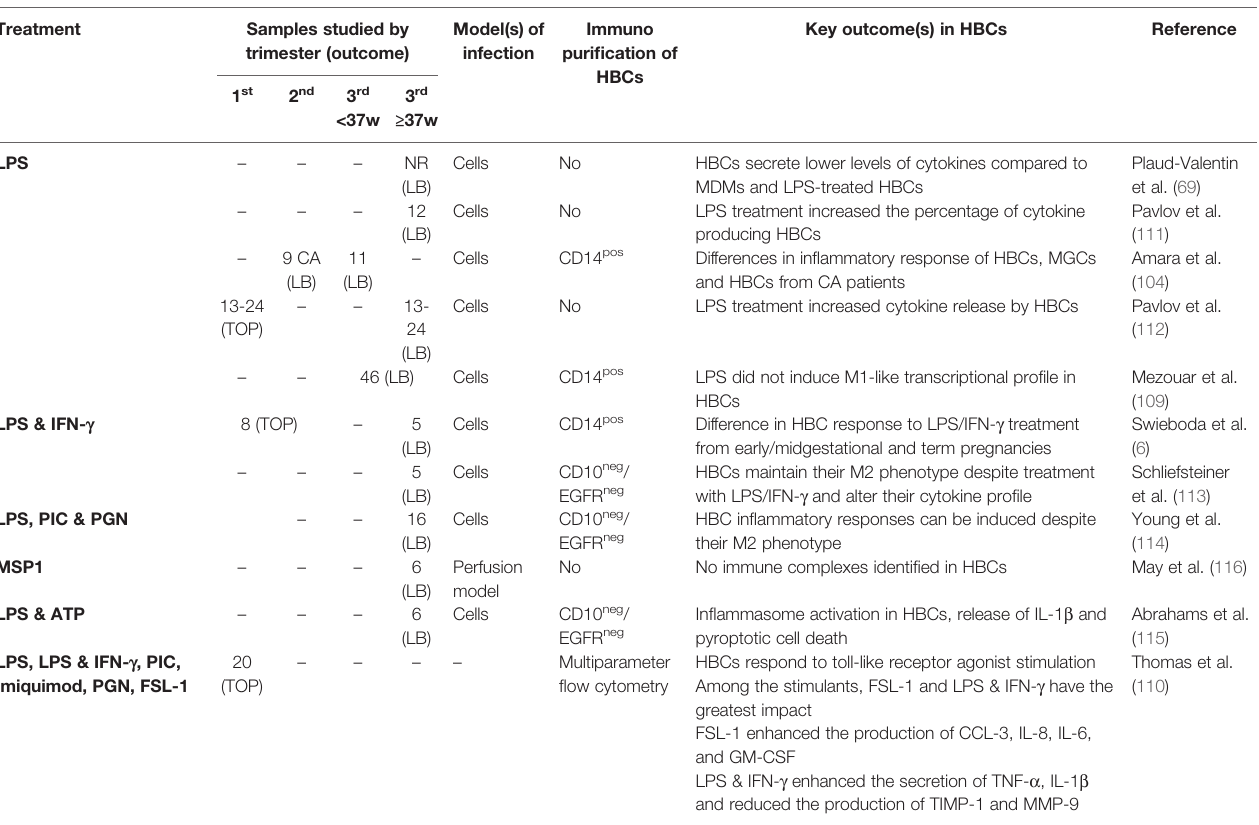
TABLE 5 | Studies that investigated HBC response to PAMP(s) treatment in vitro. .